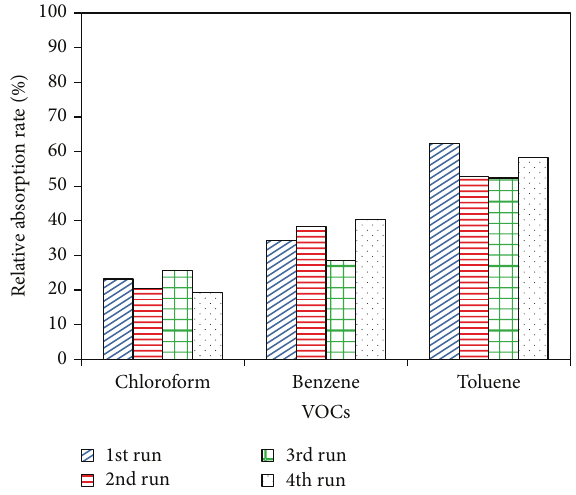
Figure 8: VOC absorption capacity of 30 wt% LPs containing PU film in different